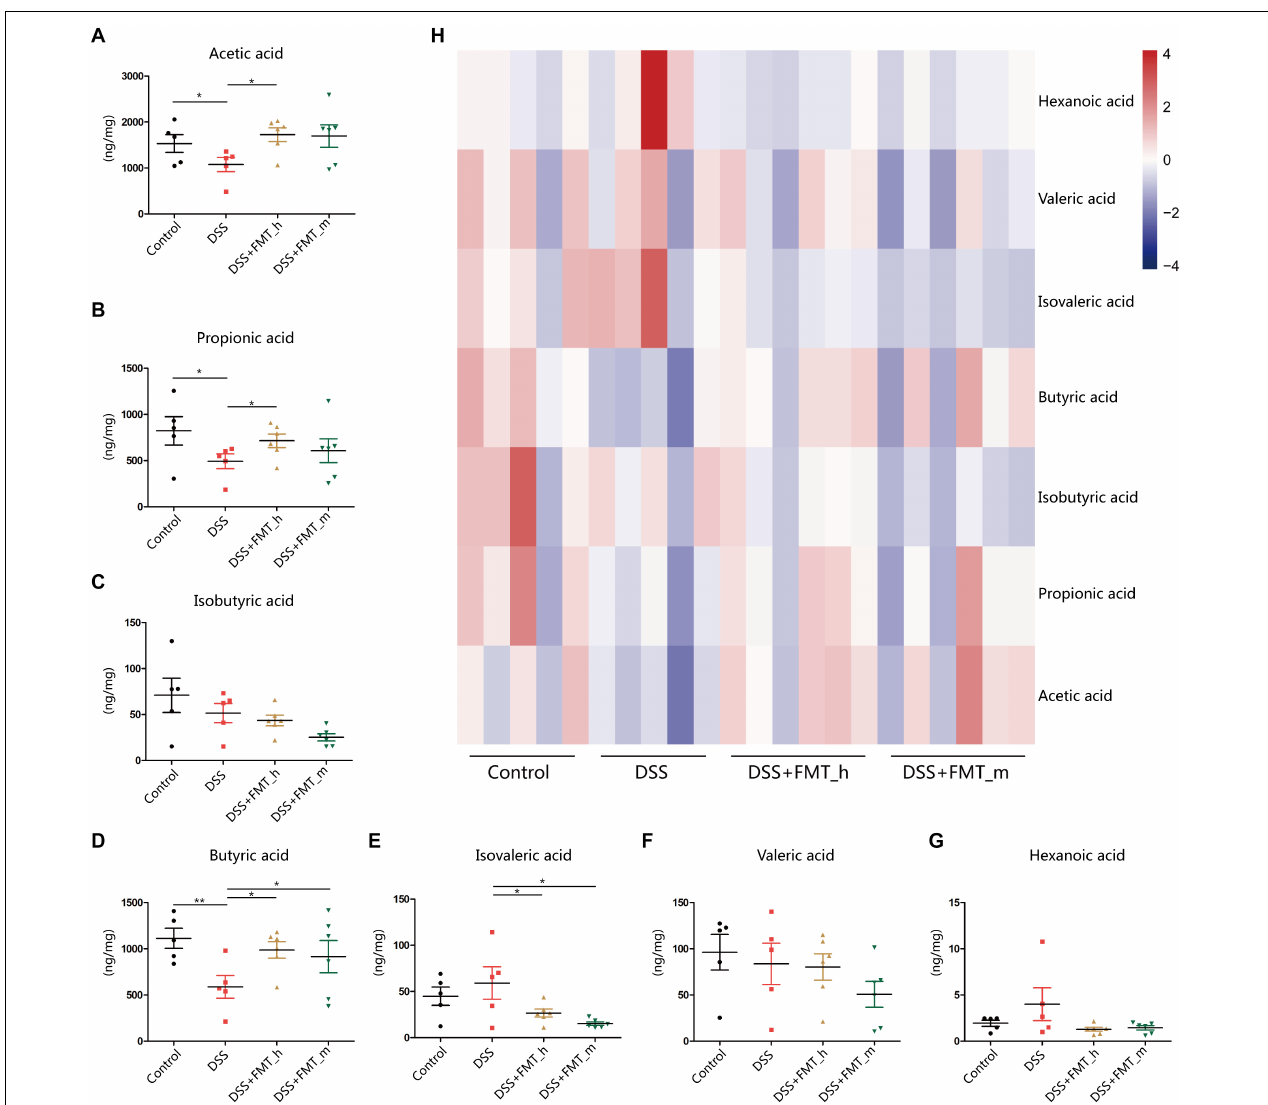
FIGURE 5 | FMT restores some types of fecal short-chain fatty acid (SCFA) levels in colitis mice. (A–G) The contents of fecal SCFA types in each group of mice. (H) Heatmap analysis of the contents of different types of fecal SCFAs in mice. * p < 0.05, ** p <